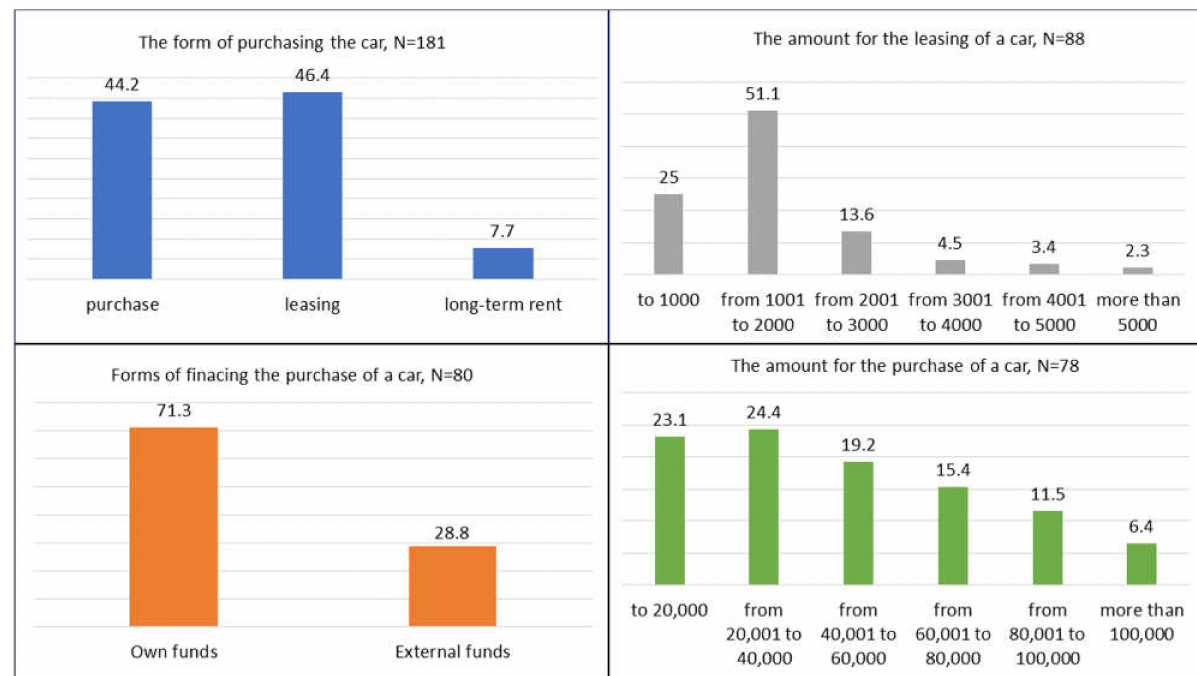
Figure 4. Sources and forms of financing the purchase of a car by microenterprises and the amount for the purchase or leasing of a car (%,